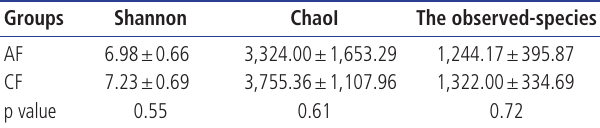
Table 1. The alpha diversity index (calculated at a depth of 10,200 sequences) of bacterial communities from goats fed at a completed feed (CF) or all forage (AF) diet (mean±SD, n = 12) Groups Shannon ChaoI